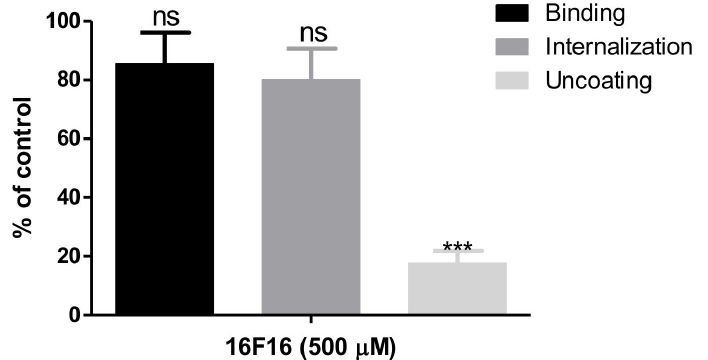
Figure 6. HAstV-8 requires PDI for uncoating during virus infection. Caco-2 cells were pre-treated with 16F16 (500 µ M) for 1 h at room temperature. Then, viral binding, internalization, and uncoating assays were performed as described under Material and Methods. Data are expressed as percentage of the cell-bound (first bar) or internalized (second bar) virus, as determined by RT-qPCR, as compared to cells treated with DMSO, which was taken as 100%. The third bar represents the percentage of viral infectivity observed of the neutral red-labeled virus exposed to light as compared to the same virus kept in the dark. The arithmetic means ± SEM from three independent experiments performed in duplicate is shown. *** p <